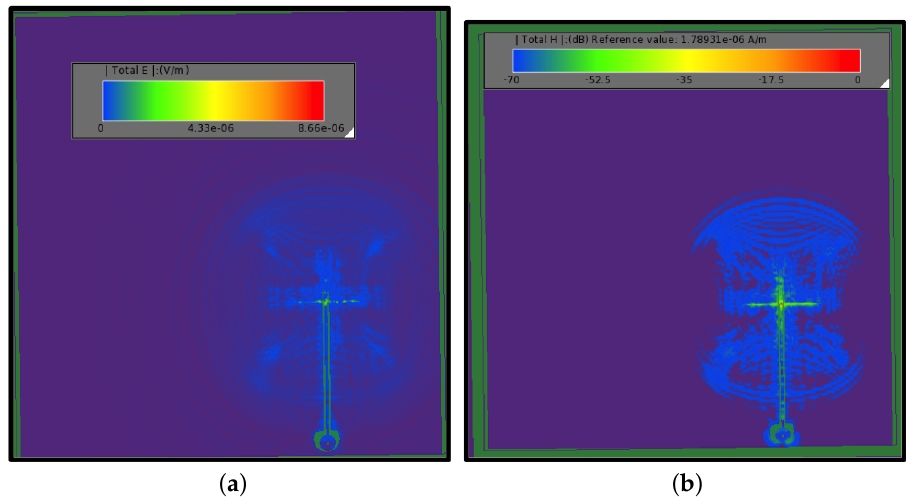
Figure 13. (cid:126) E and (cid:126) H field simulations on the RABE transmission line. ( a ) Electric ( (cid:126) E ) field. ( b ) Magnetic ( (cid:126) H ) field.